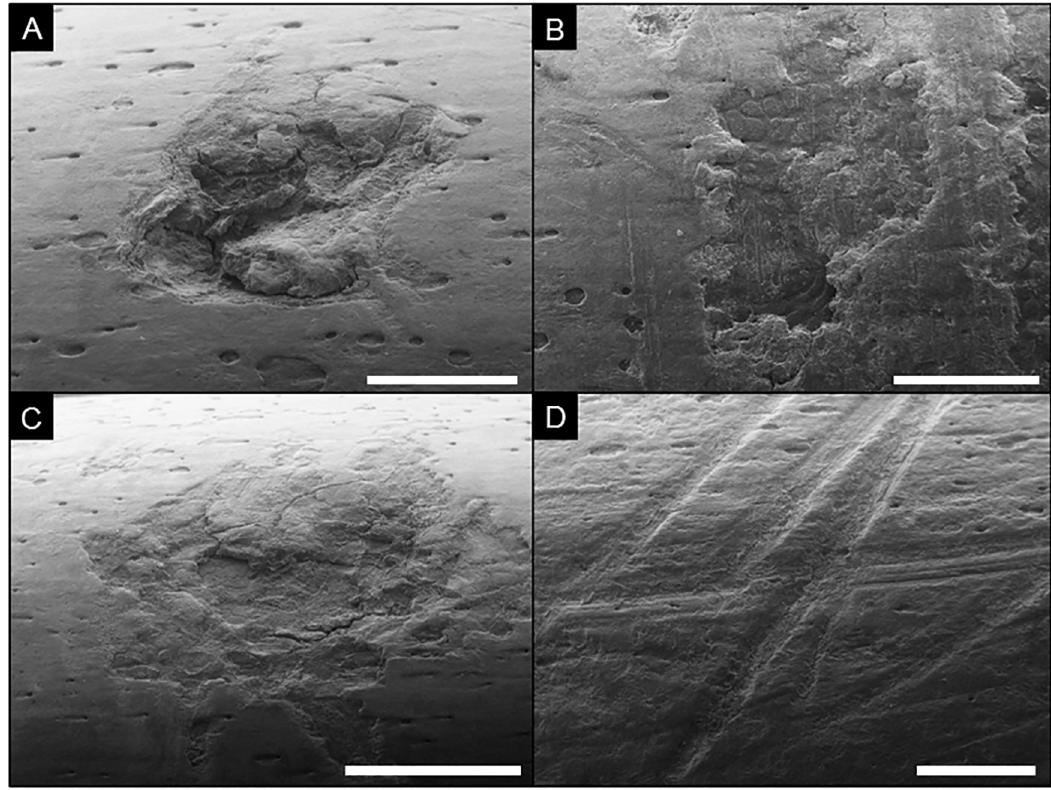
Fig 4. Experimental lithic-tool damage on goat bones under SEM. A) Percussion pit; notice the roughness and cracking that is not apparent on the air-scribe damage depicted in Fig 3B and 3D; scale bar = 2 mm. B) Irregularly shaped percussion pit with abundant (vertically oriented) microstriations; scale bar = 2 mm. C) Percussion pit with associated microstriations and fine-scale fractures; scale bar = 1 mm. D) Multiple, cross-cutting cut marks with internal microstriations and smooth margins; scale bar = 2